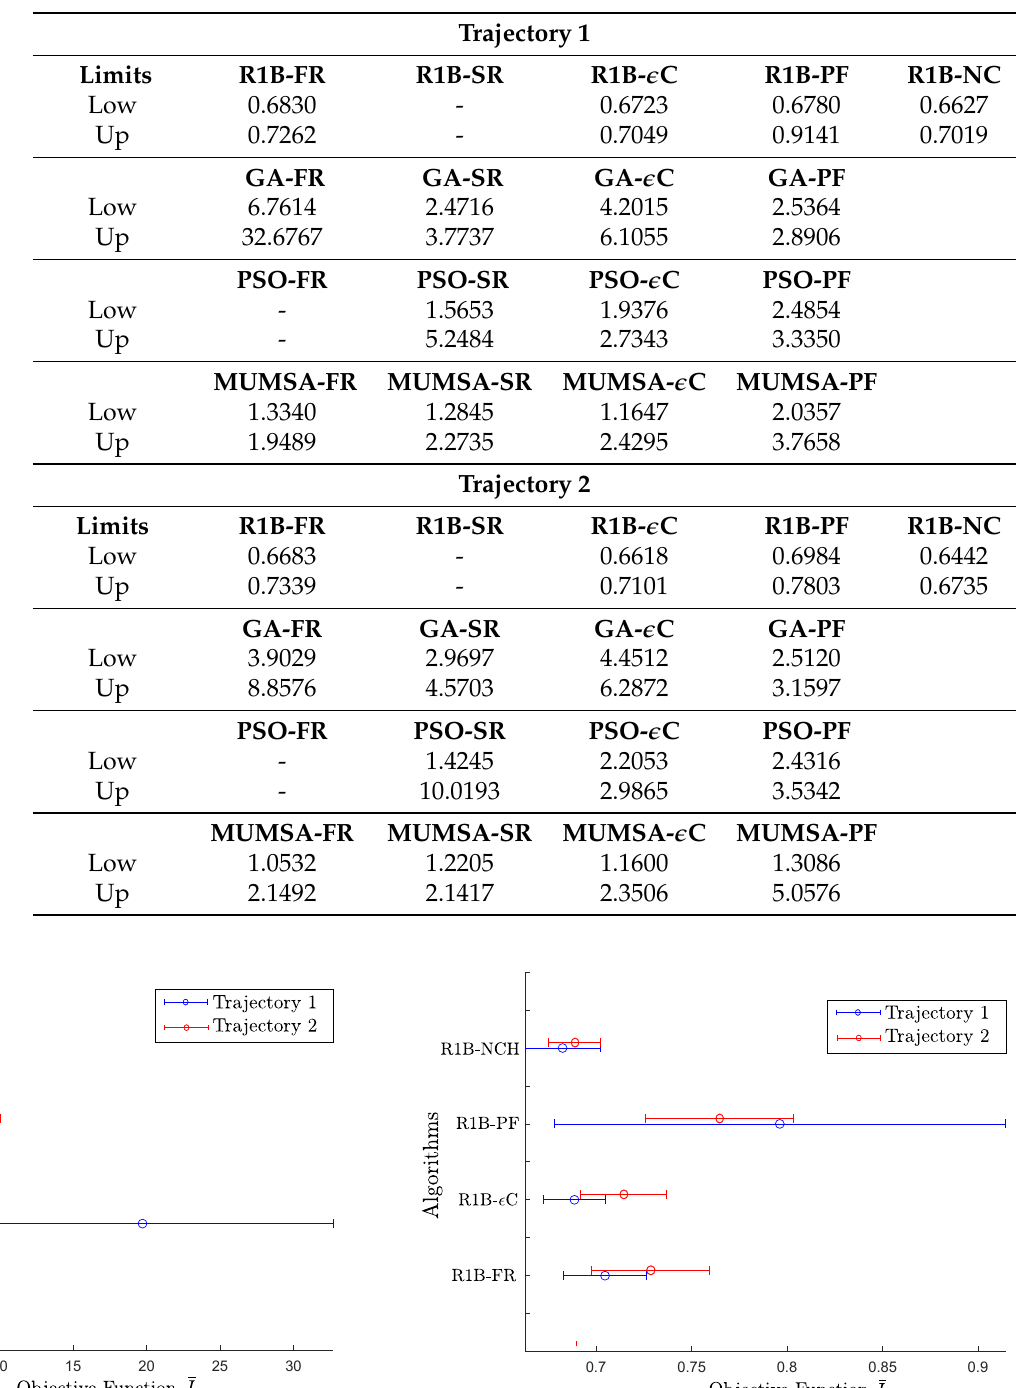
Table 12. Confidence interval values of algorithms for the study case 2 in both trajectories.